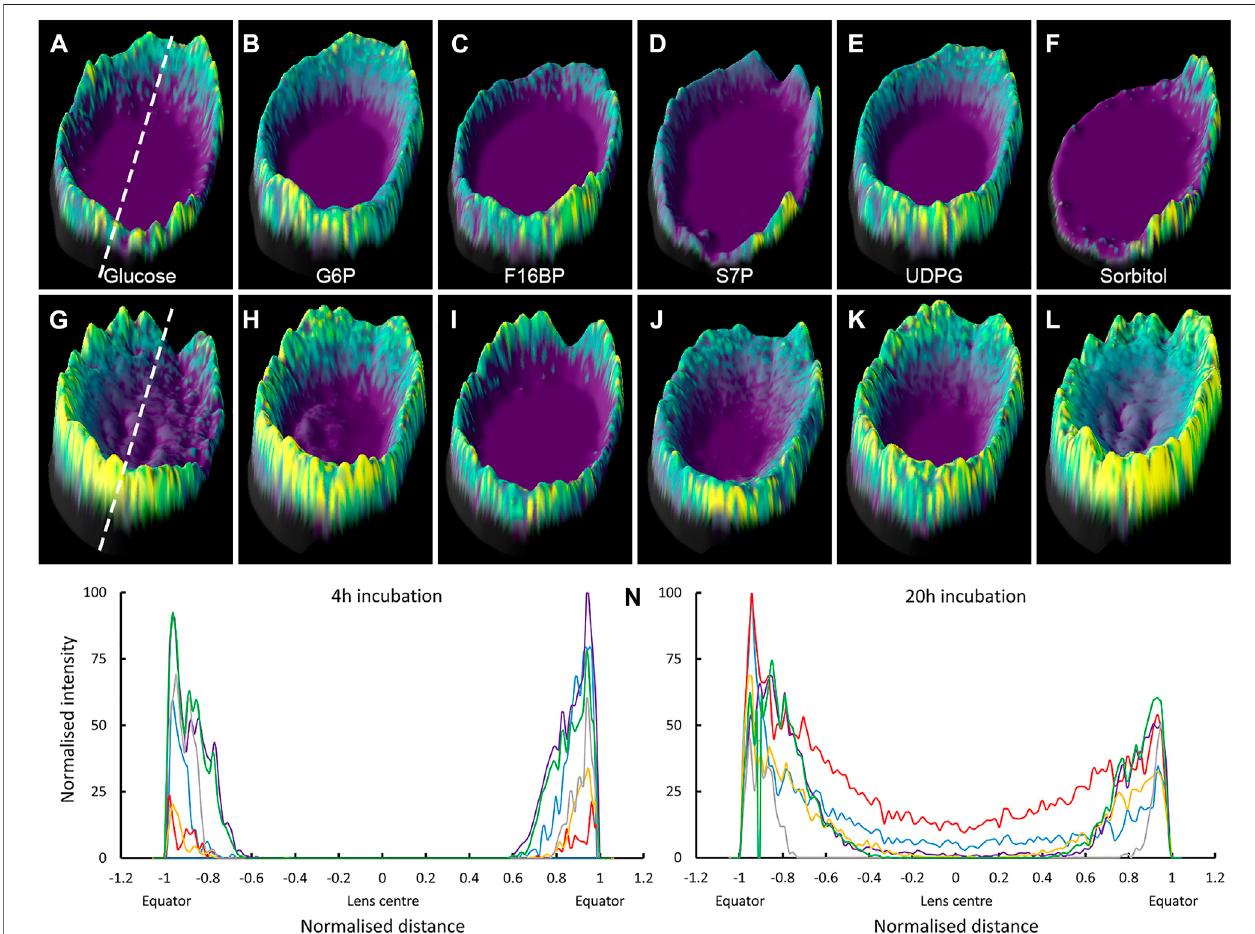
FIGURE 7 | Signal intensity plots of SIL glucose and metabolites showing presence in nucleus over time. 3D intensity plots of SIL metabolite signals obtained in bovine lenses organ cultured for 4 h (A – F) and 20 h (G – L) in SIL glucose AAH. Lenses orientated with anterior surface to the right. (A,G) SIL glucose; m/z 221.0528, (B,H) SIL G6P; m/z 265.0432. (C,I) SIL F16BP; m/z 345.0106, (D,J) SIL S7P; m/z 295.0510, (E,K) SIL UDPG; m/z 571.0722, and (F, L) SIL sorbitol; m/z 223.0686. DashedlinesindicateregionsusedtogeneratesignalintensityplotsusedtocomparespatialdifferencesinSILmetaboliteaccumulationafter4 h (M) and20 h (N) of incubationinSILglucose. Blue =SILglucose, red =SILsorbitol, purple =SILG6P, yellow =SILS7P, grey =SILF16BP, green =SILUDPG,G6P=glucose-6-phosphate, F16BP = fructose-1,6-bisphosphate, S7P = sedoheptulose-7-phosphate, UDPG =